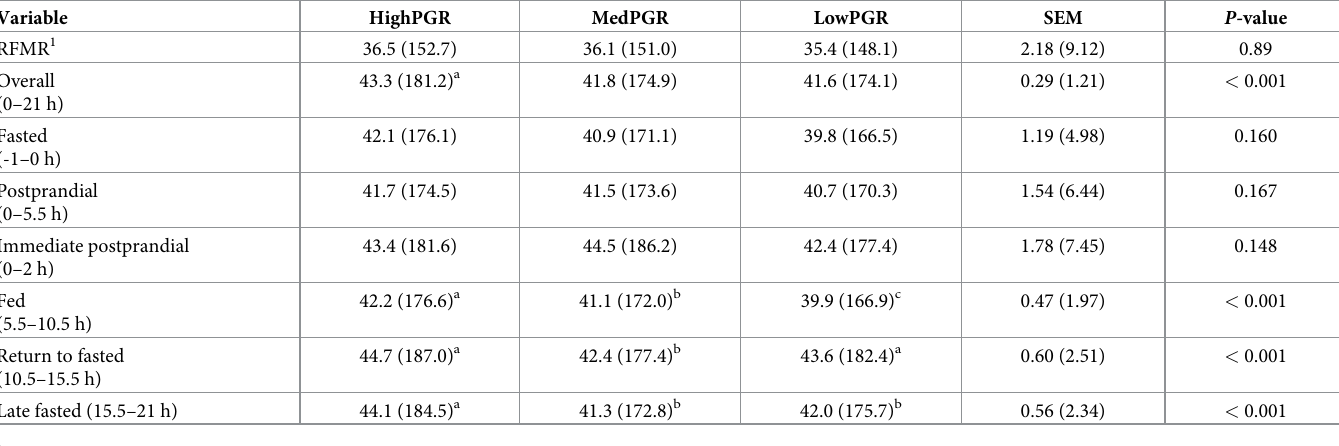
Table 3. Energy expenditure in kcal/kg d -1 (and kJ/kg d -1 ) of cats (n = 19) consuming three commercial diets differing in